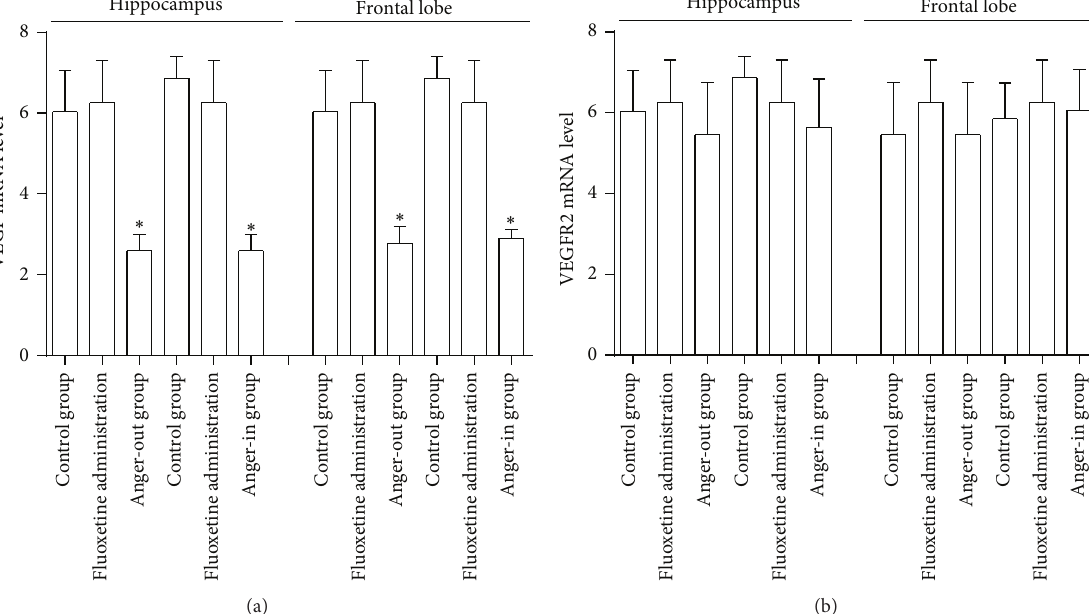
Figure 5: Quantitative analysis ( 𝑛 = 5 ) in VEGF mRNA (a) and VEGFR2 mRNA (b) of hippocampus and frontal lobe. Control, anger-out, anger-in, fluoxetine treated anger-out, and fluoxetine treated anger-in groups were tested ( ∗ 𝑃 < 0.05